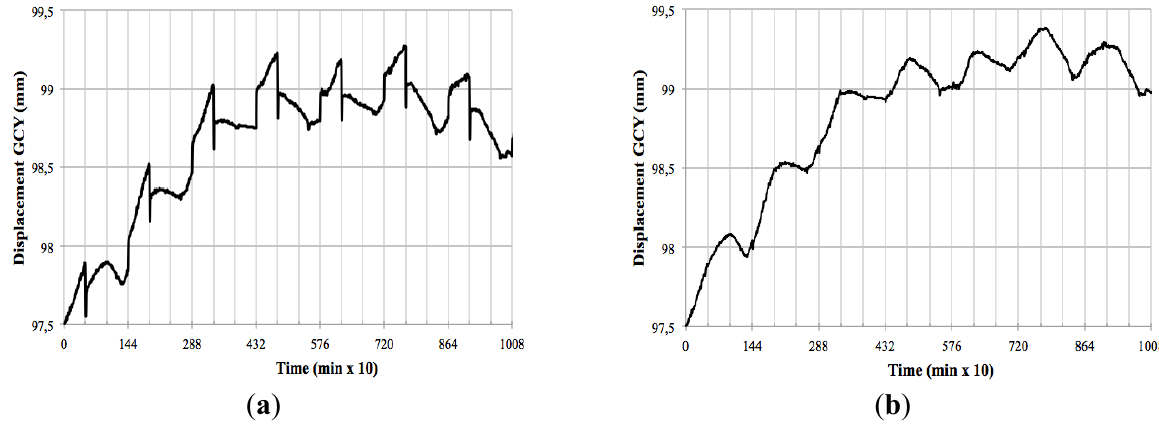
Figure 12. Displacement on the center of gravity center of an Opuntia cladode. ( a ) without correcting algorithm; ( b ) after application of correcting